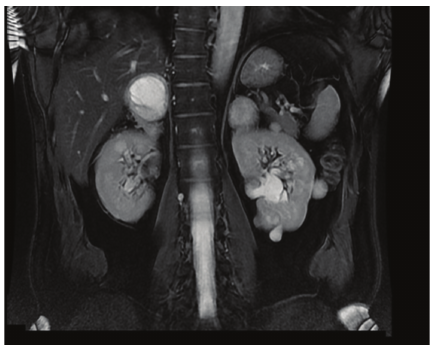
Figure 2: T2-weighted MR image in the coronal plane demonstrat- ing bilateral, adrenal masses and renal cysts. The large adrenal mass on the right side has almost completely replaced the adrenal tissue.